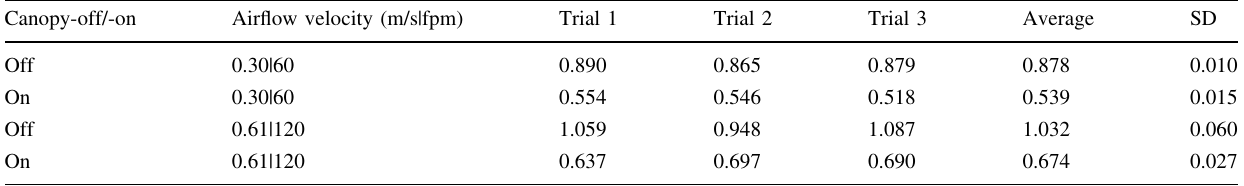
Table 9 Ratios calculated for the CAC at 10-in. height underneath the canopy using Medium Fan #2 Canopy-off/-on